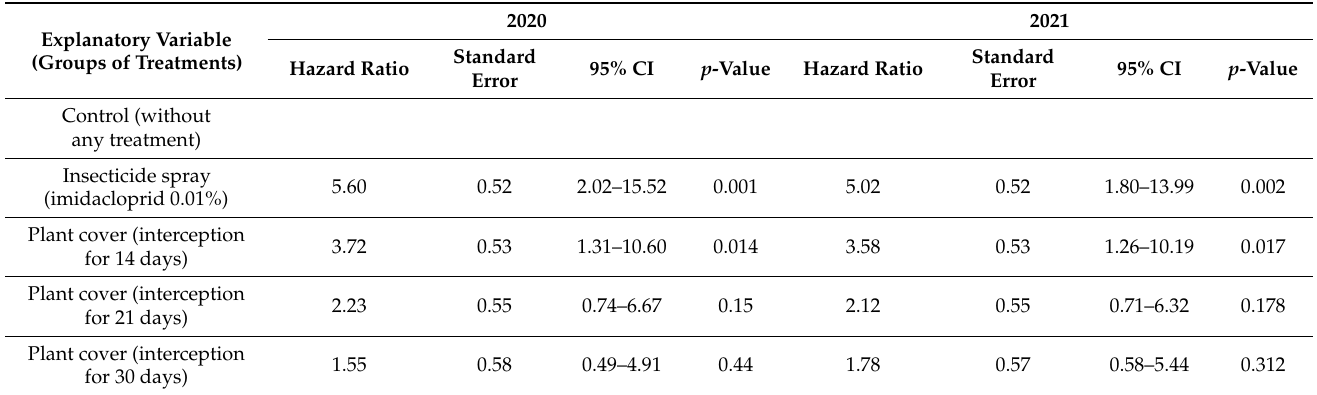
Table 1. Cox models for different periods of plant cover (interception) in relation to leaf curl infec- tion in susceptible chilli genotype (HPH-1041) observed at IARI experimental field, New Delhi, in 2020 and 2021.